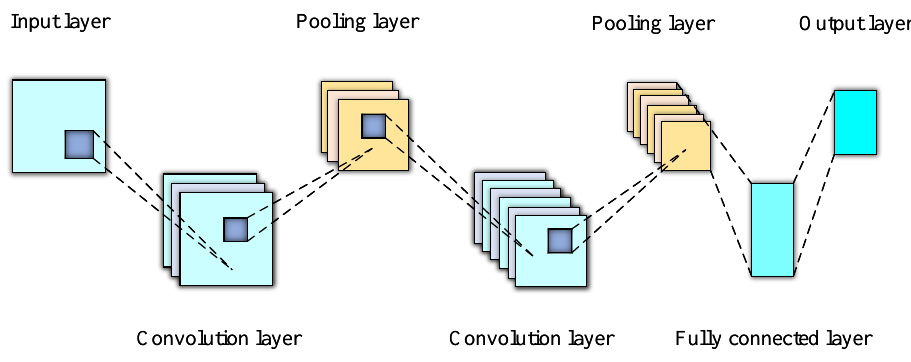
Figure 1. Structure diagram of